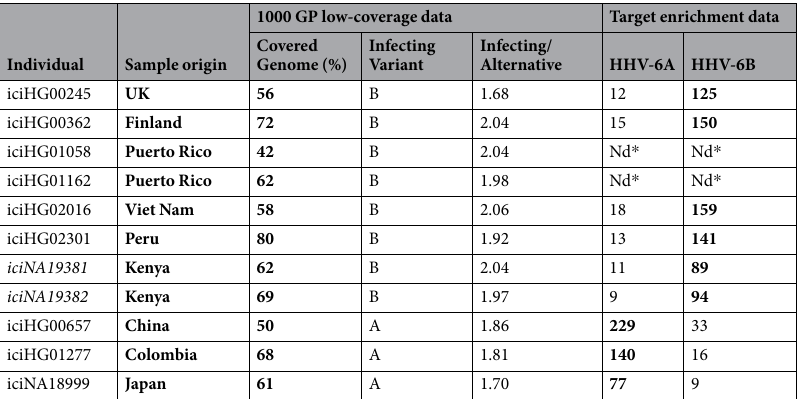
Table 1. Median viral coverage before and after target enrichment. Results for HHV-6 mapping performed on the 1000 Genome Project selected individuals (on the left), and on the sequences generated through target enrichment. On the left the length of the complete virus genome covered after quality filters is shown as percentage of the whole genome. Proportion of mapping reads between the species for which there is a higher number of mapping reads (dominant) and the alternative one (alternative) is also shown. On the right the median values for the whole genome are shown for both species. First-degree family members are marked in italic. * No data due to unavailability of biological sample for target